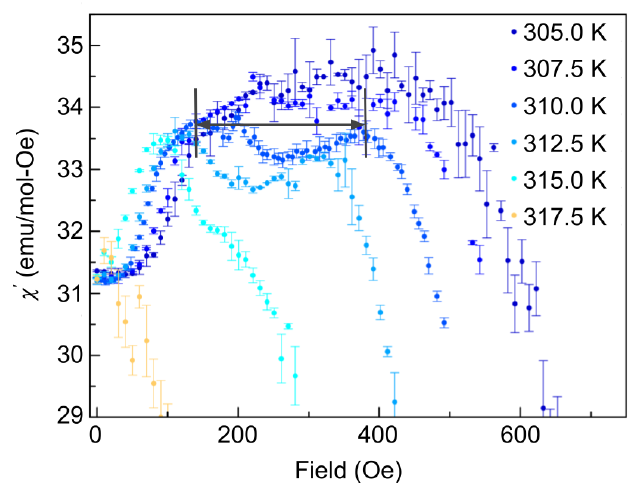
Figure 7. The temperature dependence of AC magnetic susceptibility per mol of Co 8 Zn 8 Mn 4 over a range of 305 K–317.5 K after increasing magnetic fields from 0 Oe to 500 Oe in a 100 Hz driving field, with an amplitude of 0.1 Oe. Low–high temperature corresponds to dark blue–lighter coloured curves. The skyrmion phase is most pronounced at a temperature of 310 K and is observed to persist in the dip anomaly between 100 Oe and 450 Oe (contained within the region bounded by the lines, as indicated by the arrow). The field value at the minimum of the dip determines the largest and most robust skyrmion phase; these temperature and field parameters are then used for SANS measurements on the